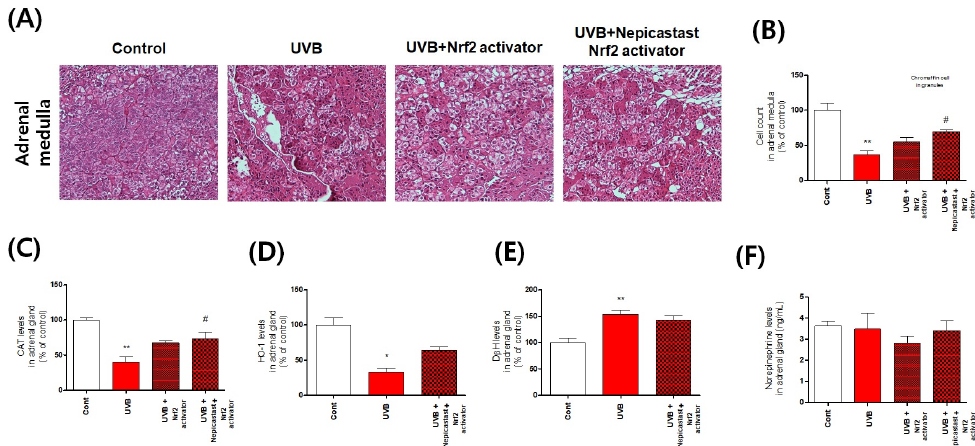
Figure 6. Effects of the dopamine- β -hydroxylase (D β H) inhibitor nepicastat and Nrf2 activator on various indices in the adrenal medulla following mouse skin exposure to chronic excessive UVB irradiation. ( A ) Representative histological analysis of an adrenal gland section damaged by exposure to UVB. ( B ) Effects of nepicastat and of its combination with the Nrf2 activator on chromaffin cell counts in granules revealed by hematoxylin/eosin staining. ( C – F ) ELISA-based quantification of the levels of the Nrf2-related enzymes CAT ( C ) and HO-1 ( D ), and of D β H ( E ) and norepinephrine ( F ). Values represent the mean ± standard error of the mean. Statistical significance of differences is illustrated as follows: * p < 0.05 and ** p < 0.01 compared with the control group and # p < 0.05 compared with the UVB